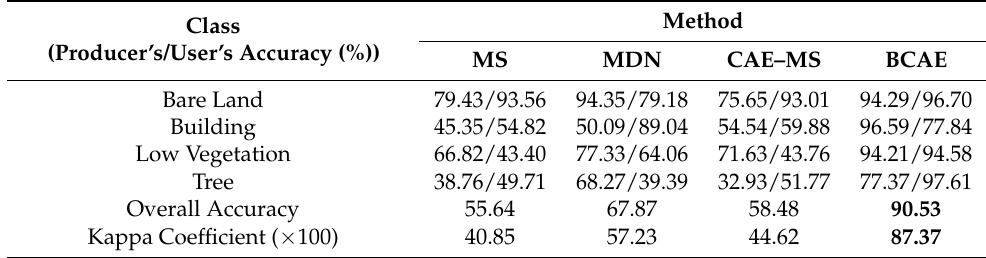
Figure 4. Clustering maps of UH dataset. ( a ) The true color composite, ( b ) the ground truth map, ( c ) MS, ( d ) MDE, ( e ) CAE – MS, and ( f ) BCAE. Table 10. A comparison between the clustering results of the UH dataset.